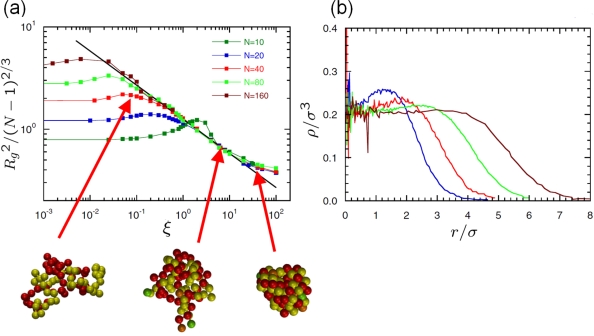
(a) Radii of gyration as a function of the interaction strength ξ for various chain lengths according to [223]. The radius of gyration Rg2 is scaled by (N – 1)2/3, where (N –1) is the number of bonds of a single chain. Also displayed are sample snapshots of the collapsed globules with N = 40 and interaction strengths ξ = 0.4, 4, 40. (b) Radial density of monomers with respect to the center of mass of a globule and interaction strength ξ = 4 for different chain lengths, N = 20 (blue), N = 40 (red), N = 80 (green) and N = 160 (brown).